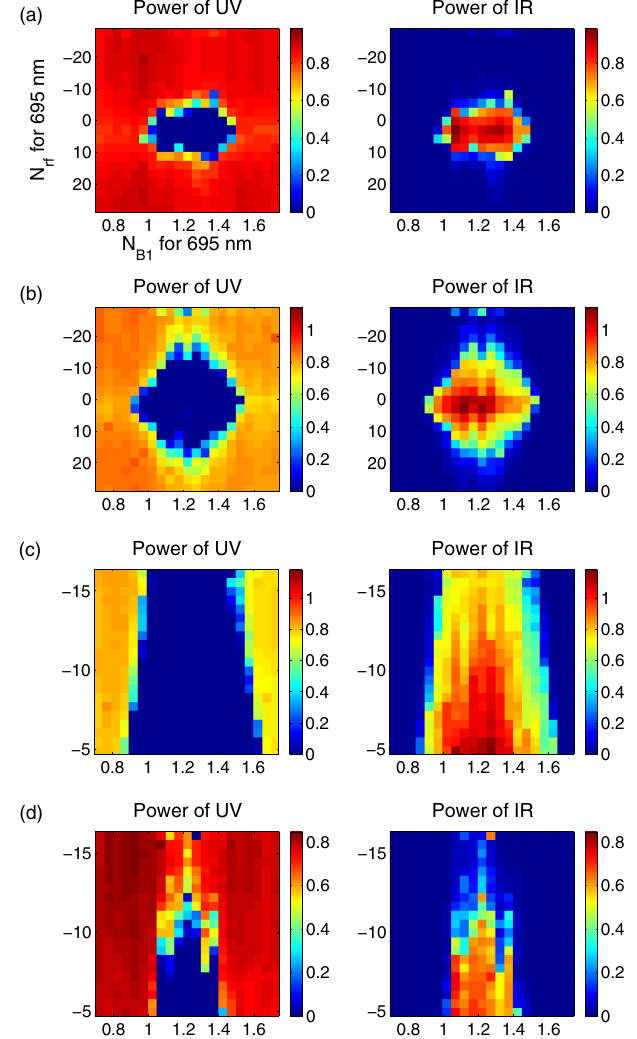
FIG. 12. Two-color lasing phace spaces with the three-undu- lator configuration and loss curves L3. (a) N B 2 ¼ 0 . 47 for 368 nm. (b) N B 2 ¼ 0 . 45 for 368 nm. (c) Fine tuning of N rf with N B 2 ¼ 0 . 45 for 368 nm and more preferable optical axis alignment for IR lasing. (d) Fine tuning of N with N B 2 ¼ 0 . 45 rf for 368 nm and less preferable optical axis alignment for IR lasing. In (a) and (b), the rf detune is scanned from − 0 . 5 Hz ¼ − 27 . 69 ) to 0.5 Hz ( N ¼ 27 . 69 ). In (c) and (d), the rf ( N rf rf ¼ − 16 . 06 ) to -0.09 Hz detune is scanned from − 0 . 29 Hz ( N rf ¼ − 4 . 98 ). In all cases, the IR and UV lasing wavelengths are ( N rf about 695 nm and 368 nm, respectively, and N B 3 ¼ 0 . The beam current is maintained between 19.99 mA and 21.13 single-color lasing (outside). The width of this region is determined by the settings of other tuning knobs as well as the beam current. Figure 11 shows the power dependence of two-color lasing on the rf detune and setting of buncher B1 and B3 in the four-undulator configuration, where the rf detune (y-axis) is converted to a relative length scale in terms ¼ C · ð Δ f =f Þ = λ of the lasing wavelength [ N , where rf rf rev FEL C is the circumference of the storage ring, f is the rev